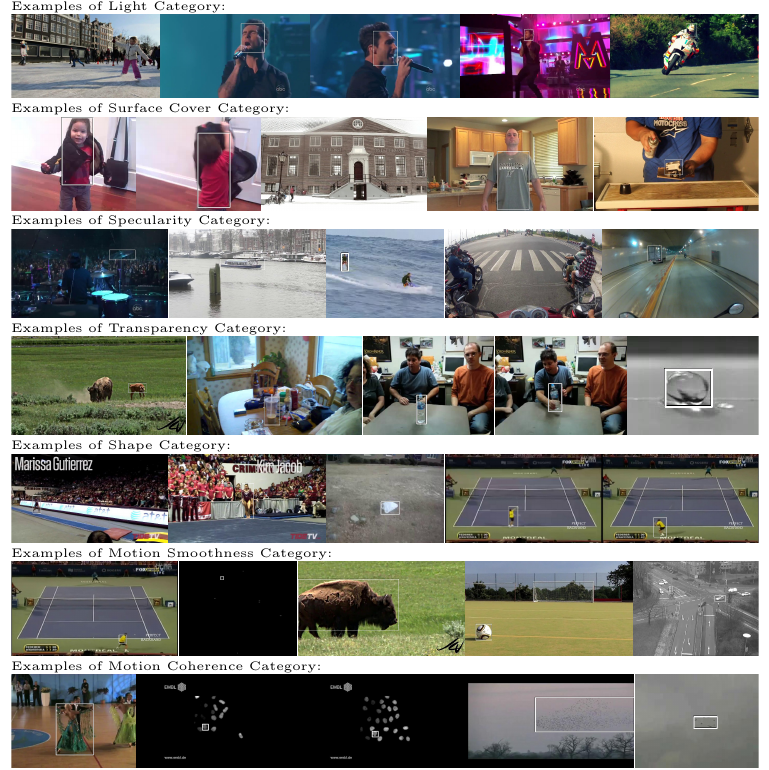
Figure 4. Example videos from the ALOV dataset (first 7 categories). Only first frames are shown. The target object is